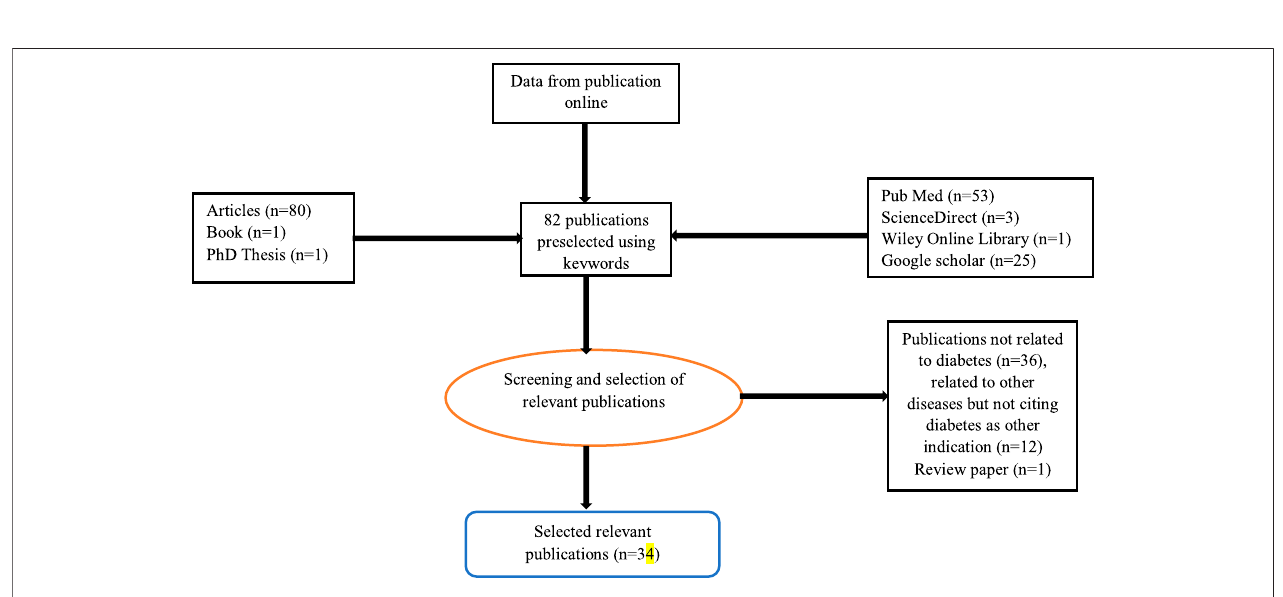
FIGURE 2 | Flowchart for the selection of relevant